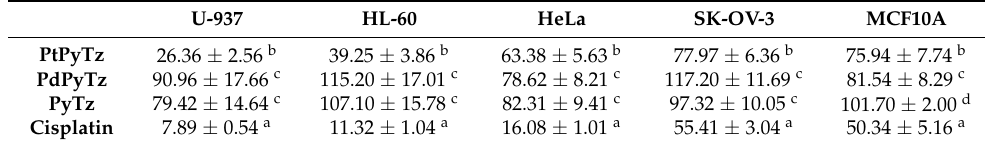
Table 3. Cytotoxicity (IC50 ± SD, µ M) of the free ligand PyTz and their Pt(II) and Pd(II) complexes towards selected tumor and healthy (non-tumor) cell